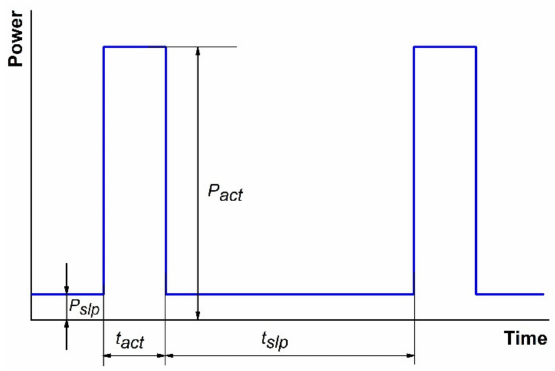
Figure 11. Load graph of the WSN power supply